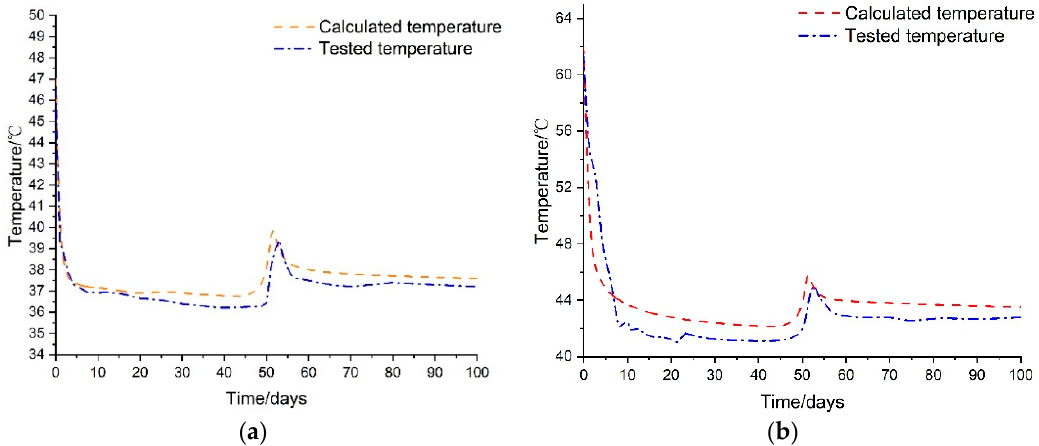
Figure 10. Comparison of primary lining temperature measured value and predicted value: (a) Test Location 1 and (b) Test Location 2.